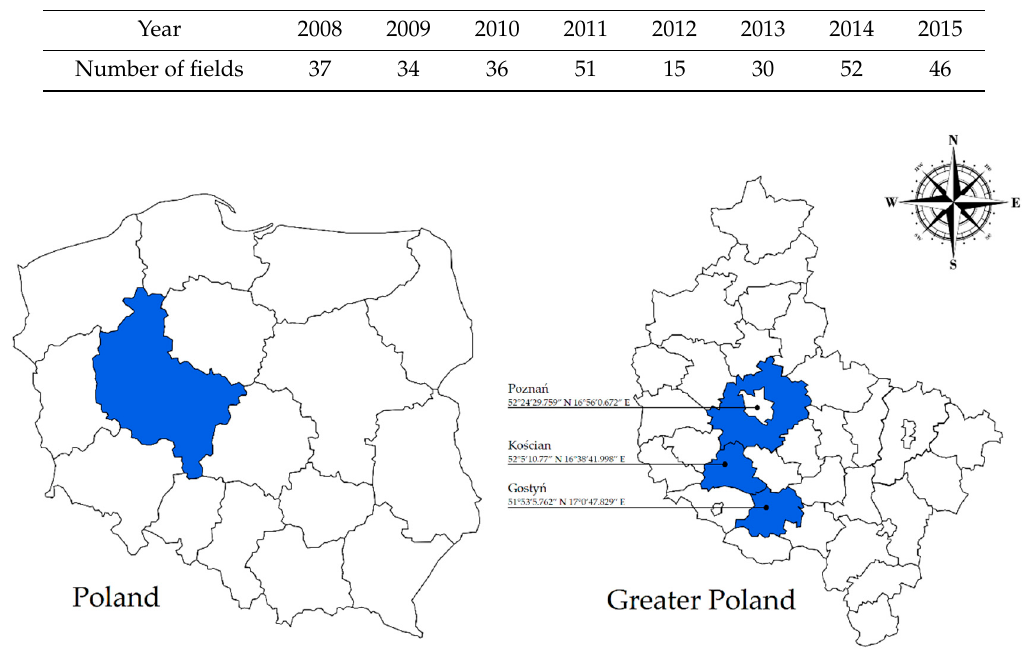
Figure 1. Research Figure 1. Research area. Table 1. The number of arable fields of winter wheat divided into two sets, A and B.